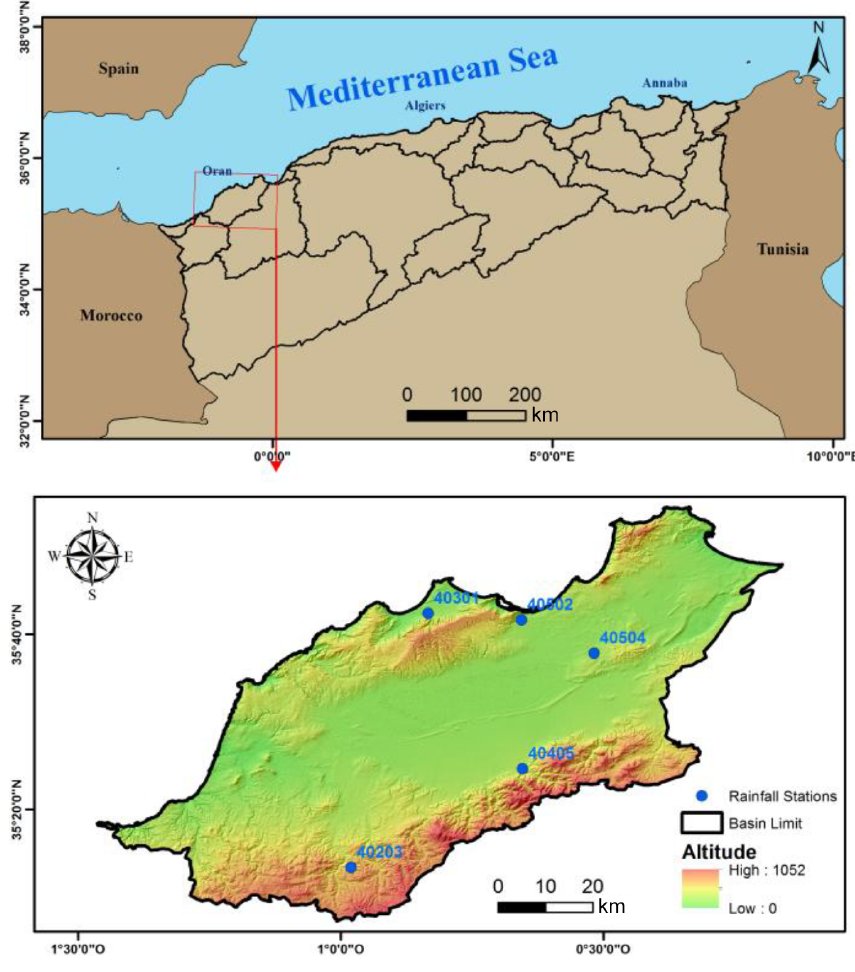
Figure 1. Localisation géographique des postes pluviométriques. Tableau 1. Caractéristiques géographiques et statistiques des stations pluviométriques de la zone d’étude. Code Nom stations X (km) Y (km) 040203 Oued